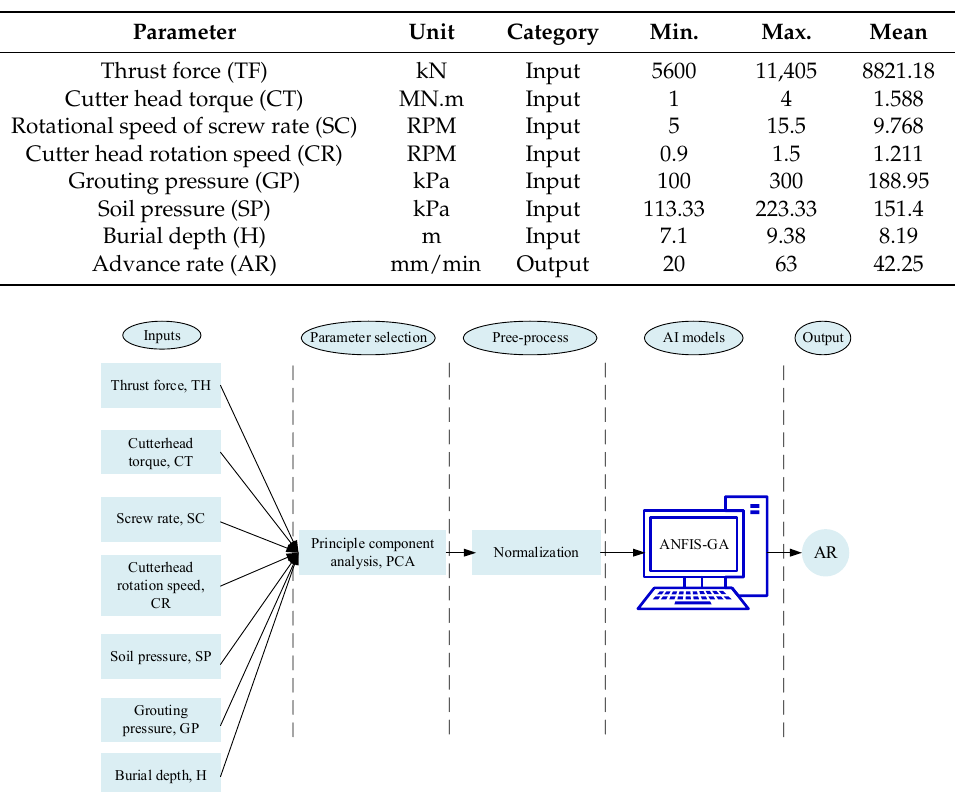
Figure 4. Geotechnical profiles of the construction site. Table 2. Statistics of the database in this study.